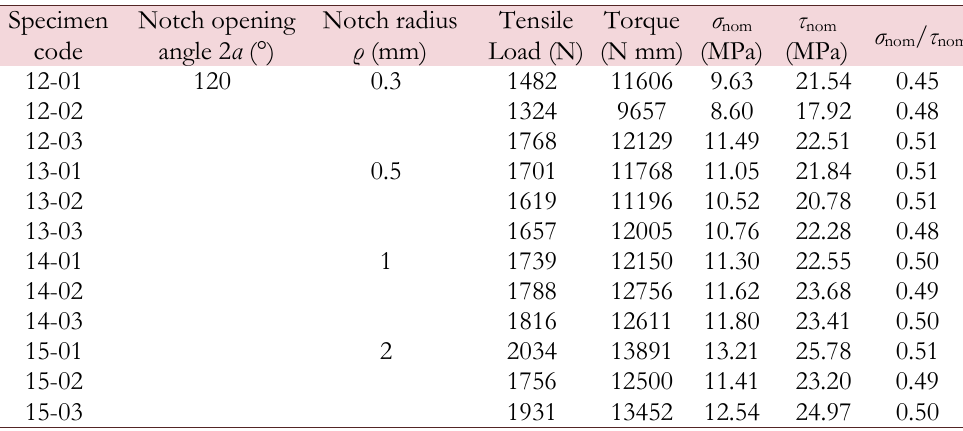
Table 3: Experimental results in the case of σ nom / τ nom = 0.5; notch depth p = 3